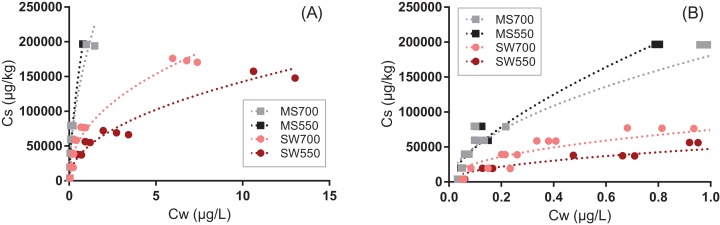
Sorption of pyrene to four types of biochars produced from soft wood (circles) and miscanthus grass straw (squares) at 550 °C and 700 °C (SWP550, SWP700, MSP550 and MSP700, respectively).The lines represent the fits with the Freundlich model (all fitted parameters are presented in Table S4). Graph (B) is a zoom of graph (A).